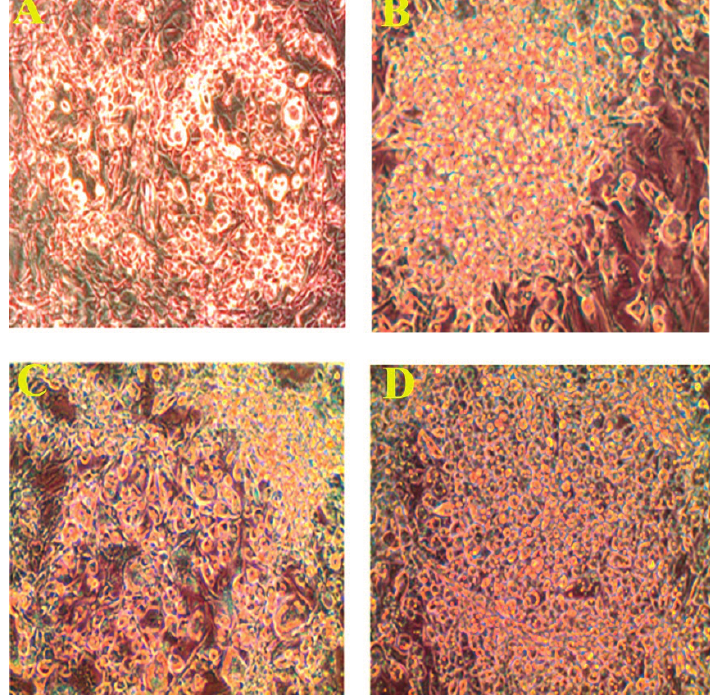
Figure 2. Microscopic (magnifications ×20) view of adipocyte differentiation on the 10th day. ( A ) Control; ( B ) 25 µM; ( C ) 50 µM; ( D ) 100 µM. Below 25 µM did not influence adipocyte